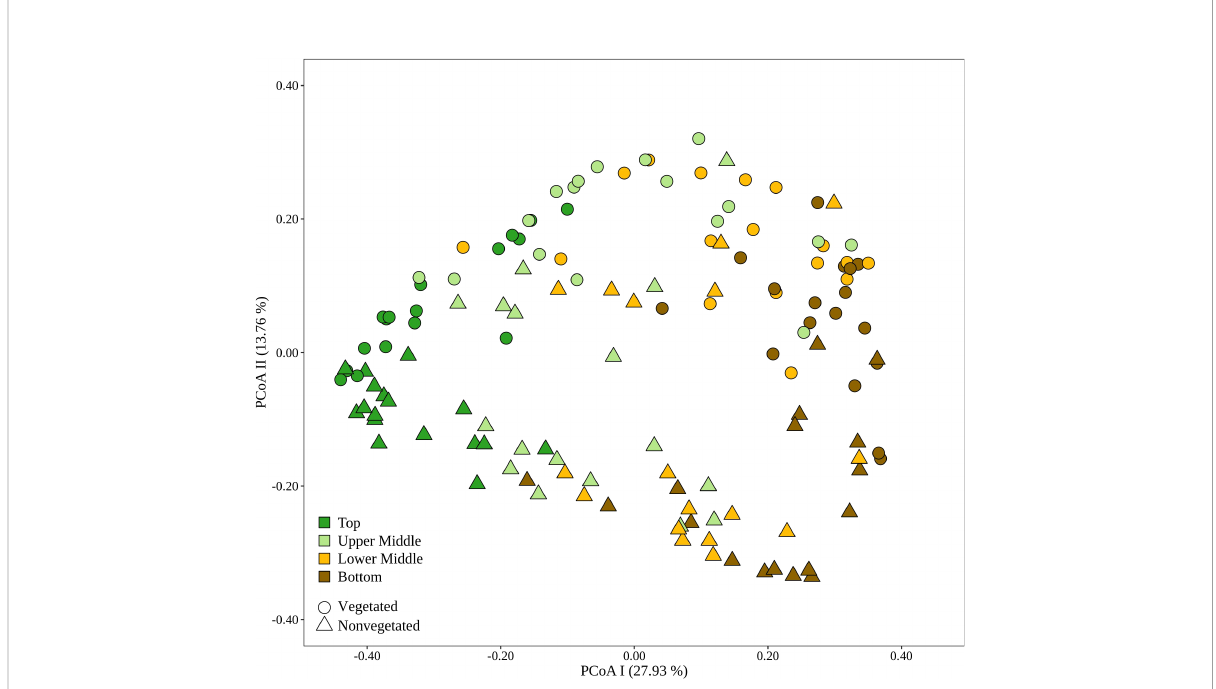
FIGURE 3 Principal Coordinates Analysis (PCoA) of Bray-Curtis dissimilarities based on OTU abundances of sediment microbial communities sampled in the Bay of Saline. Samples from different sites are labelled with different symbols while samples from different sediment layers are indicated by colour. The proportion of explained variation by each axis is shown on the corresponding axis in